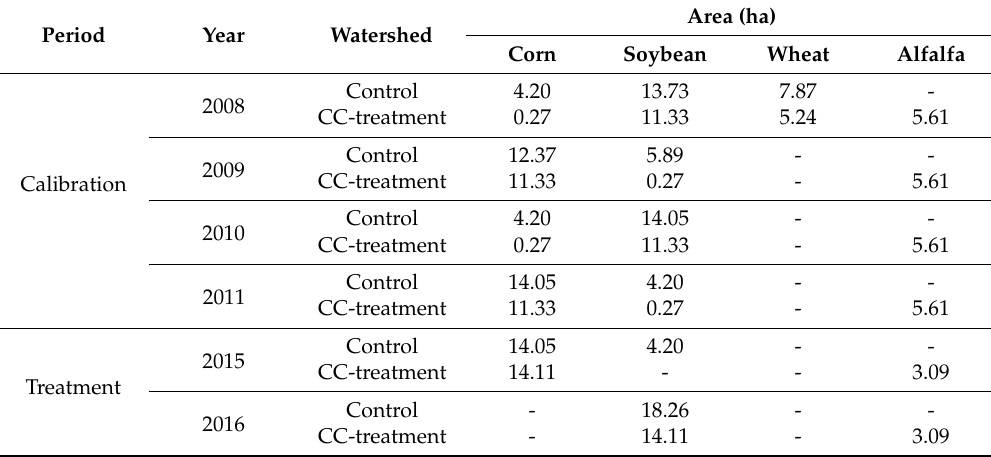
Table 1. Total area in each watershed under corn, soybean, wheat and alfalfa during calibration and treatment